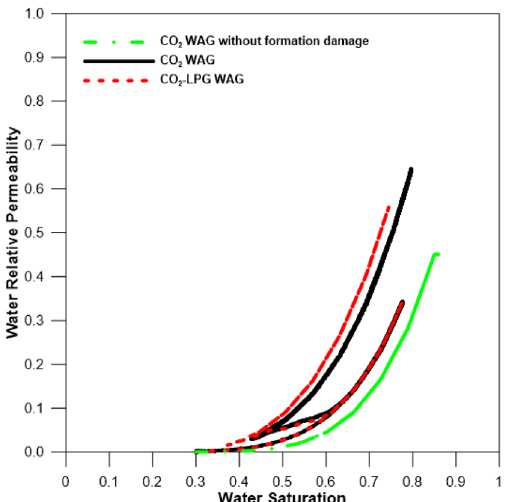
Figure 8. Water relative permeability with and without formation damage during CO 2 WAG and CO 2 -LPG WAG injection.